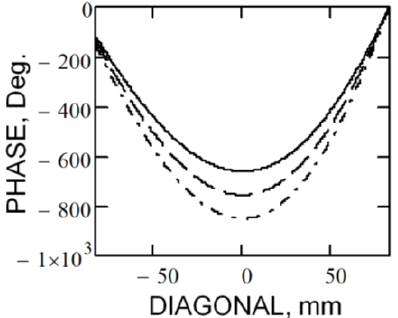
Fig. 4. The desired reflection-coefficient phase distribution along reflector with the offset feeding at 14 GHz (solid line), 16 GHz (dashed line) and 18 GHz (dash-dot